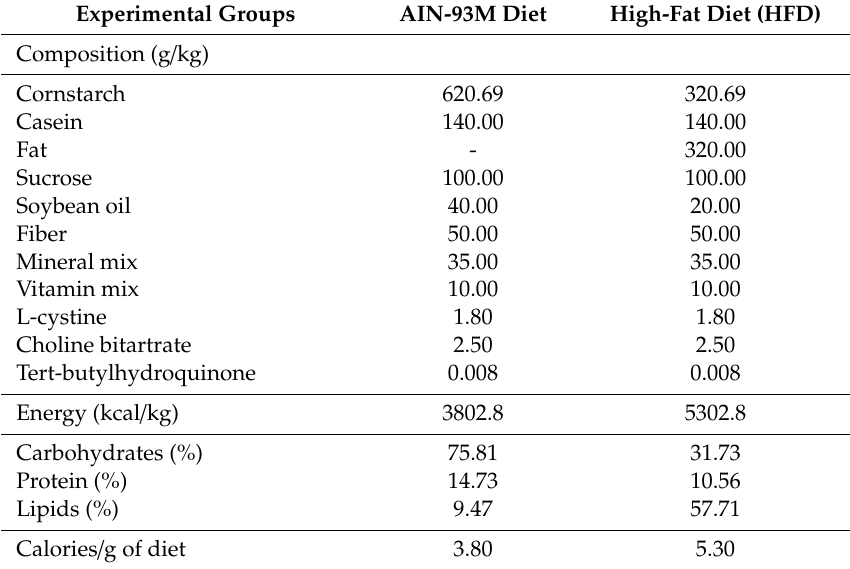
Table 1. Composition of experimental diets (g / kg